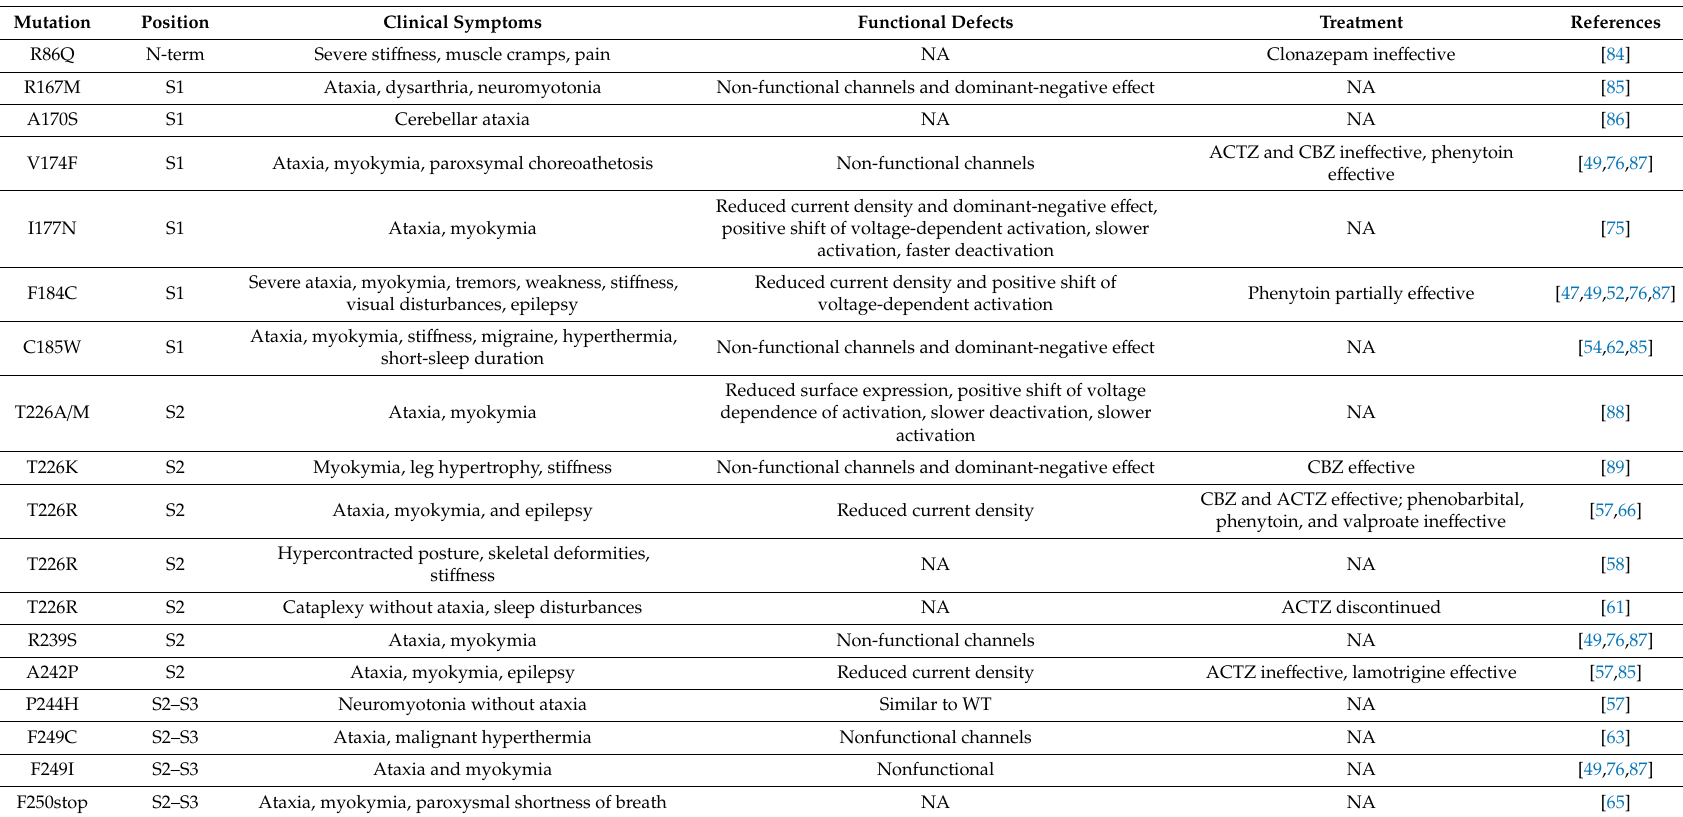
Table 1. Clinical symptoms and functional defects of identified KCNA1